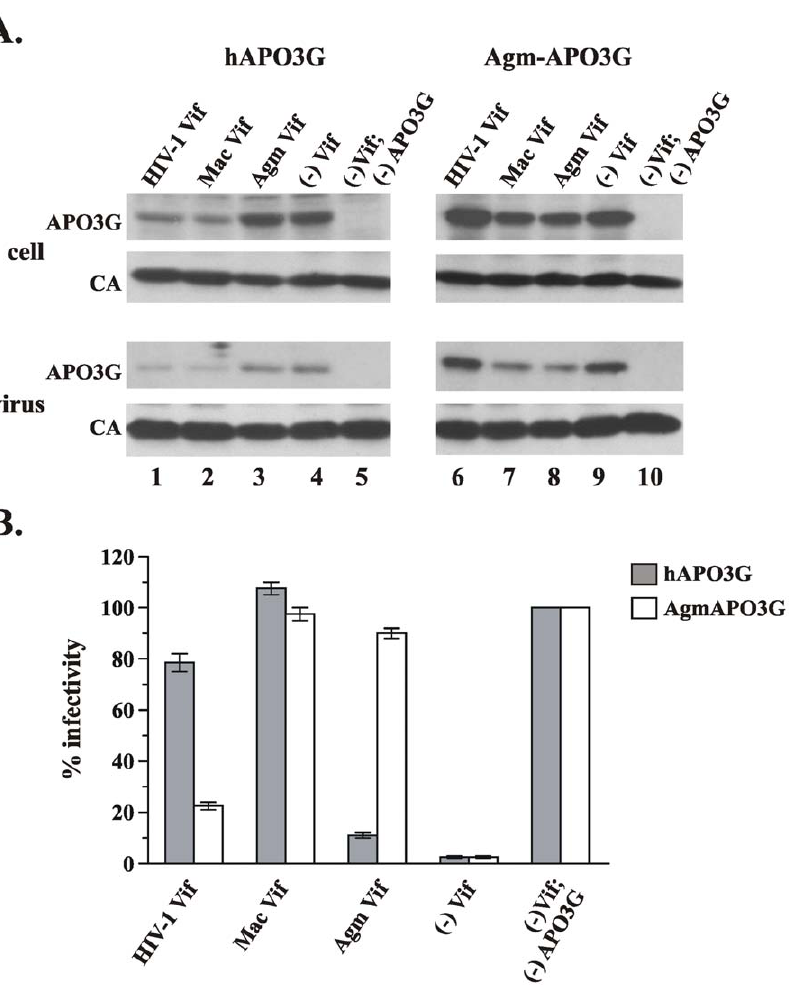
Figure 1. Activity of HIV-1, SIVagm and SIVmac Vif against human and Agm APO3G. ( A ) HeLa cells were transfected with the Vif-defective proviral clone SIVmac Vif(-) and pCDNA-hAPO3G (left panel) or pCDNA-Agm-Apo3G vector (right panel). In addition, vectors encoding HIV-1 Vif (pNL- A1/43Vif, lanes 1 & 6), Mac Vif (pNL-A1macVif, lanes 2 & 7), or Agm Vif (pNL-A1agmVif, lanes 3 & 8) were co-transfected. Vif-negative samples (lanes 4 & 9) and APO3G-negative samples (lanes 5 & 10) were included as controls. Total amount of DNA was adjusted to 5.5 m g/5 6 10 6 cells using pNL- A1vif(-) vector DNA. Whole-cell lysates and concentrated viral extracts were prepared 48 hr after transfection and aliquots from each sample were analyzed by immunoblotting for the presence of APO3G (top panel) or capsid protein (CA, lower panel). ( B ) Cell-free filtered supernatants from the cultures shown in panel A were normalized for reverse transcriptase activity and used for the infection of LuSIV indicator cells. Infected cells were harvested 24 hr later and analyzed for the expression of Tat-induced luciferase activity. Results are expressed relative to the virus prepared in the absence of APO3G (defined as 100%). Bars reflect the median and error bars indicate the range calculated from two independent infections.